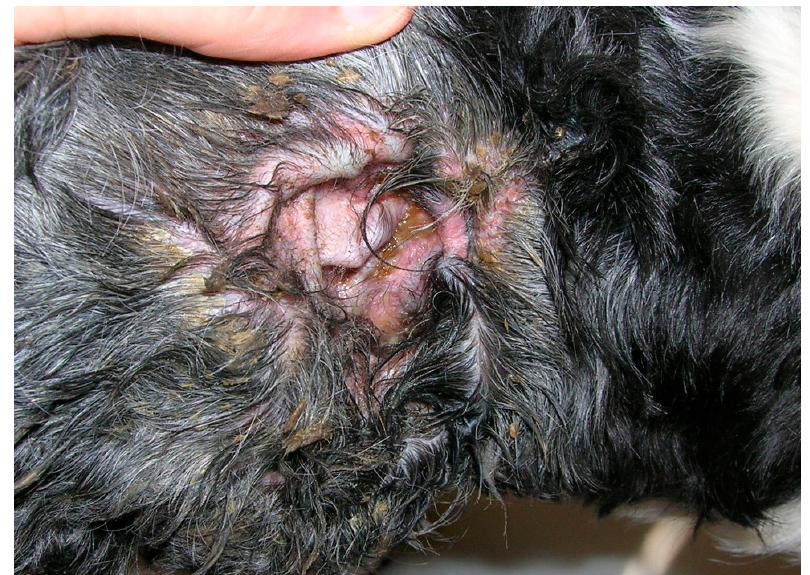
Figure 2. Malassezia otitis in a dog .